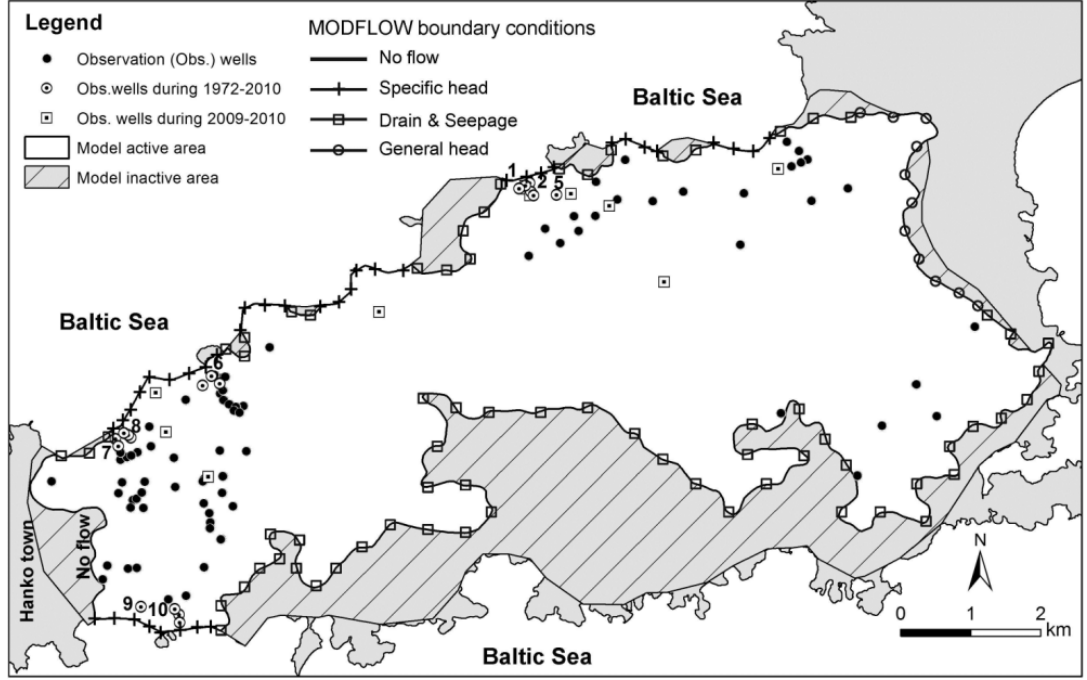
Figure 5. Boundary conditions of the model domain and locations of the observation